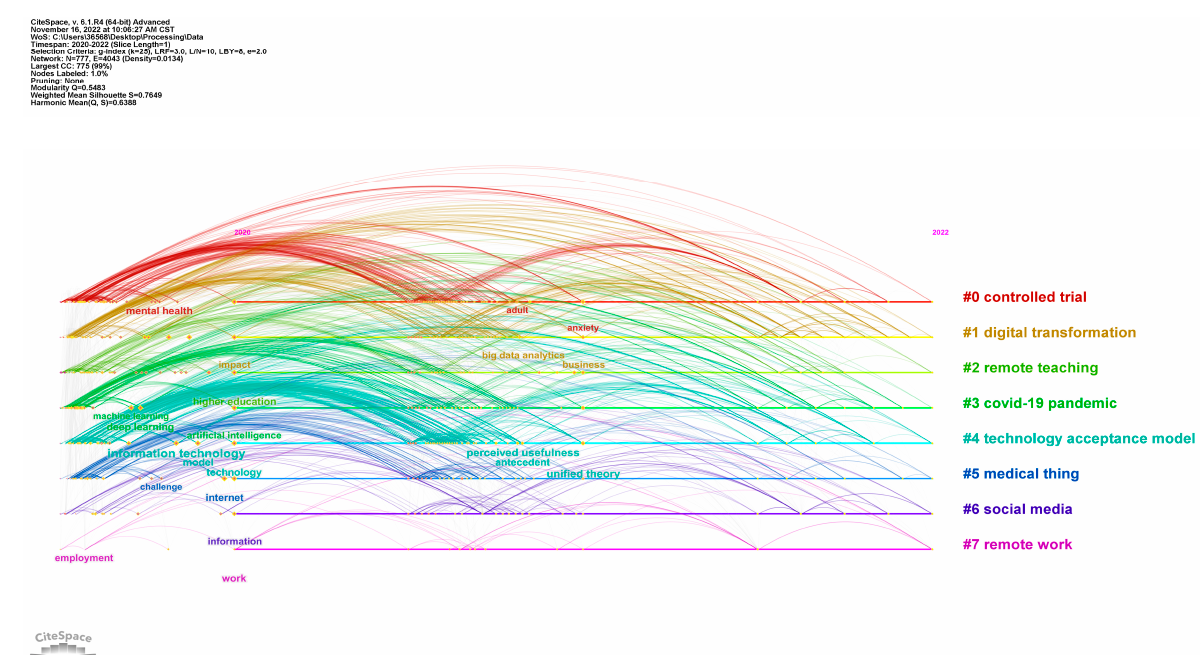
Figure 3. Keyword co-occurrence network (timeline view). This figure omits the labels of some nodes avoid congestion, which highlights the network links. The colors of links correspond to the categories. The label of a node is the keyword extracted from the article title. The horizontal axis is the publication time, and the vertical axis shows the main clustering categories.